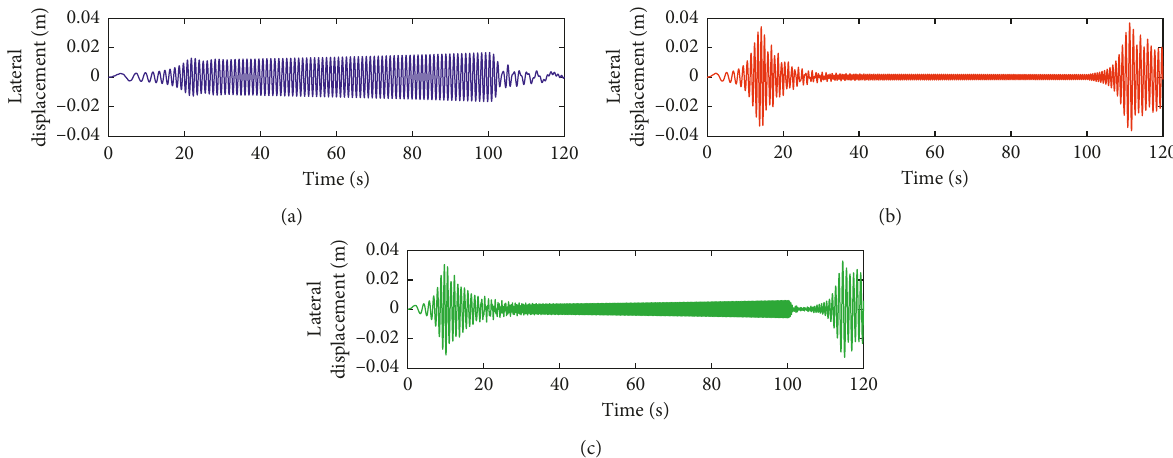
Figure 3: Lateral vibration displacements at l c /2 of the catenary rope in lifting. (a) The first-order excitation, (b) the second-order excitation, and (c) the third-order excitation of head sheave axial